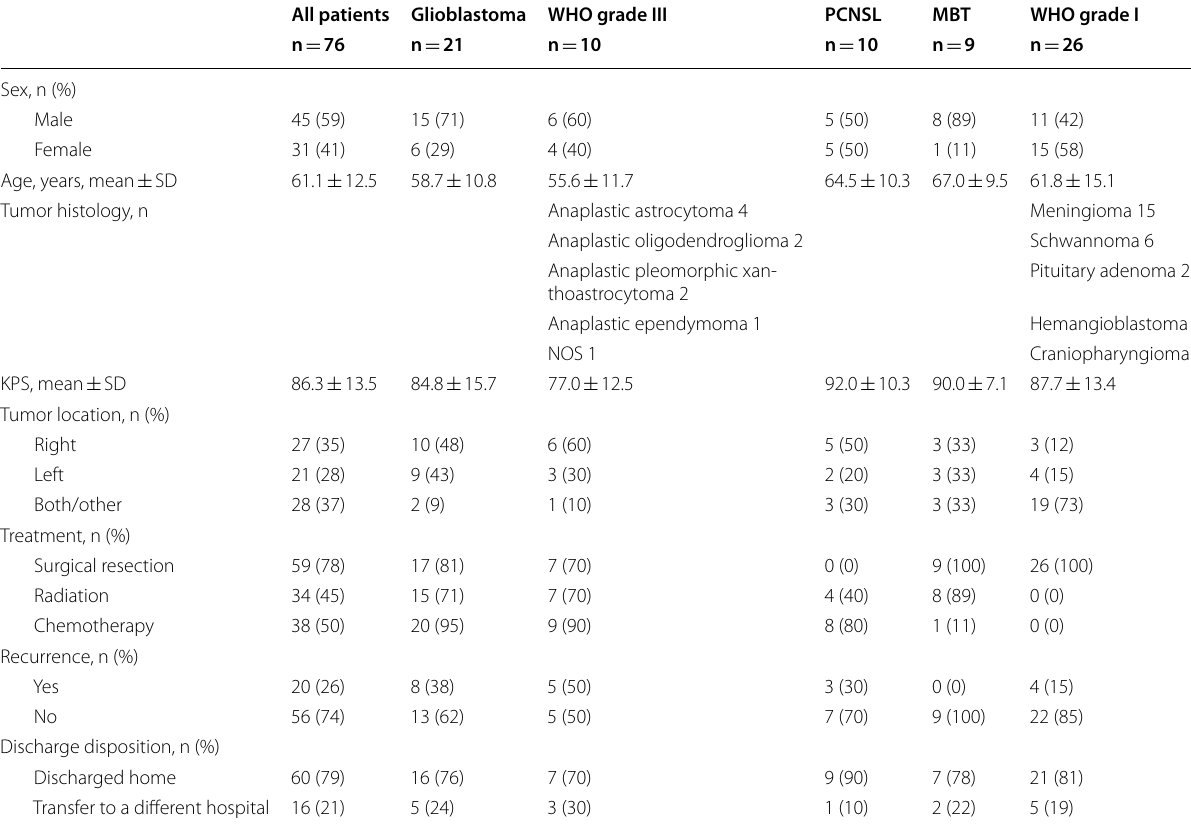
SD Standard deviation, KPS Karnofsky performance status, NOS Not otherwise specified, PCNSL Primary central nervous system lymphoma, MBT Metastatic brain tumor